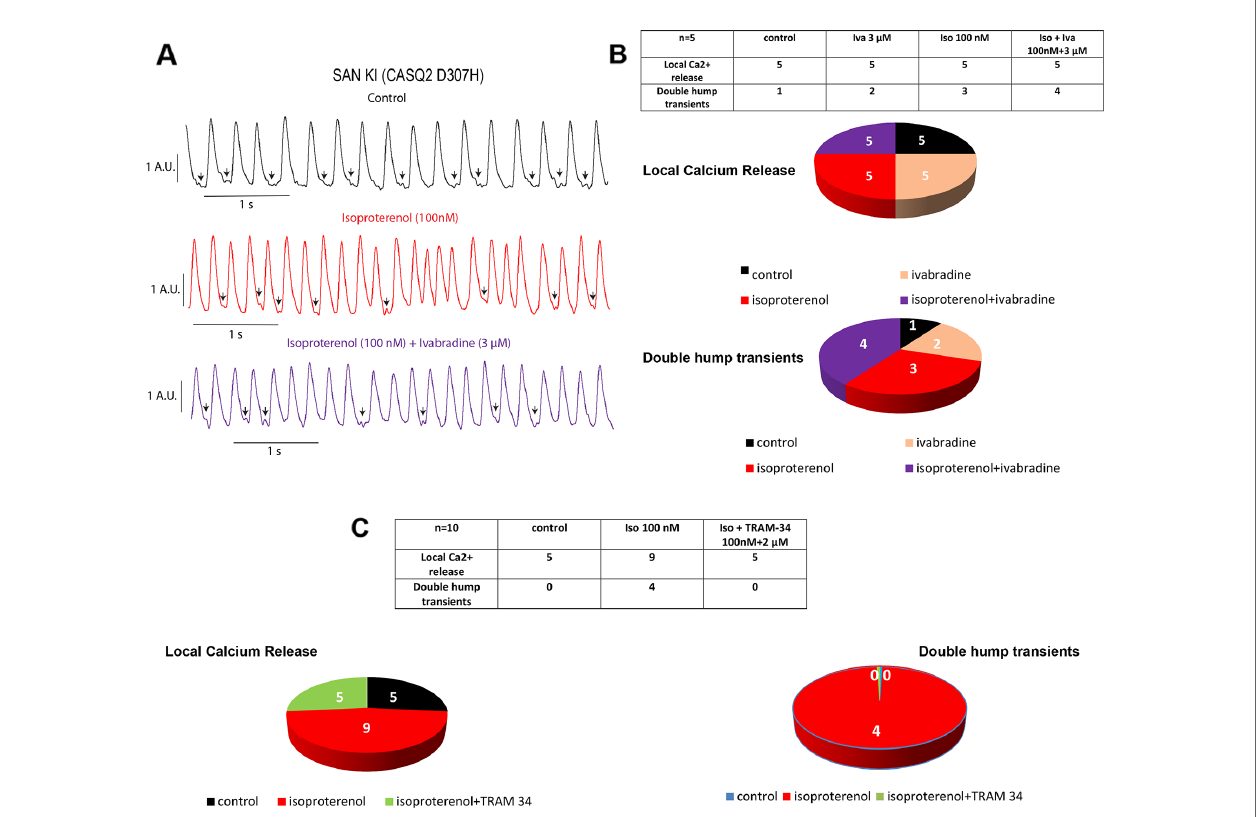
FIGURE 2 | Ivabradine does not reduce the arrhythmic phenotype of calcium transients in sinoatrial node (SAN) from CASQ2-D307H KI mice. (A) Representative traces of calcium transients obtained from the same SAN of knock-in (KI) CASQ2 D307H mice under control (black trace), 100 nM isoproterenol (red trace), and isoproterenol + ivabradine (purple trace). (B) Data summary of the aberrant calcium transients observed in SAN from KI CASQ2 D307H mice under the described conditions (n = 5). (C) Data summary of the aberrant calcium transients observed in SAN from KI CASQ2 D307H mice under the described conditions (n =